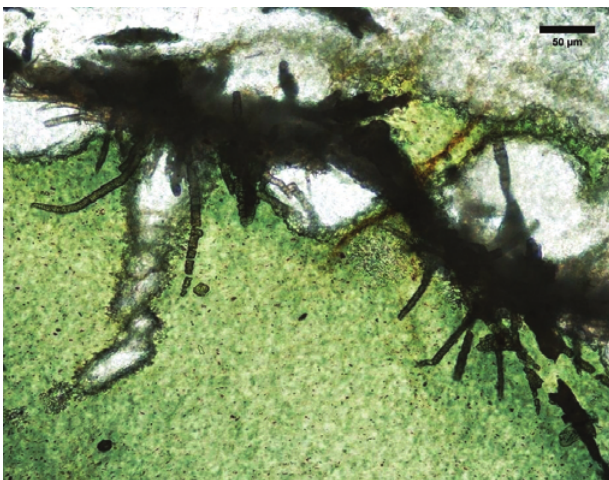
Figure 5. Photomicrograph of microbial biotextures in a surface sample of inter-pillow breccia from the Hooggenoeg Formation of the Barberton Greenstone Belt. The meta-volcanic glass comprises a greenschist facies assemblage of chlorite and quartz with titanite-filled